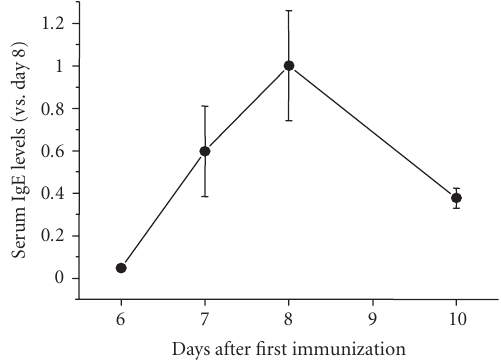
Figure 1: Changes of IgE levels in BN rats following immuniza- tion with DNP-As. The BN rats were injected with 1mg of DNP-As together with killed Bordetella pertussis (10 10 cells), followed by a single booster injection of DNP-As (0.5mg) 5 days after the first injection. Blood samples were taken from the tail veins of the rats at 6, 7, 8, and 10 days after the first injection. Serum IgE levels in the rats were determined by IgE-capture ELISA as described in the “materials and methods.” The results were expressed as means ± SD of triplicate experiments.